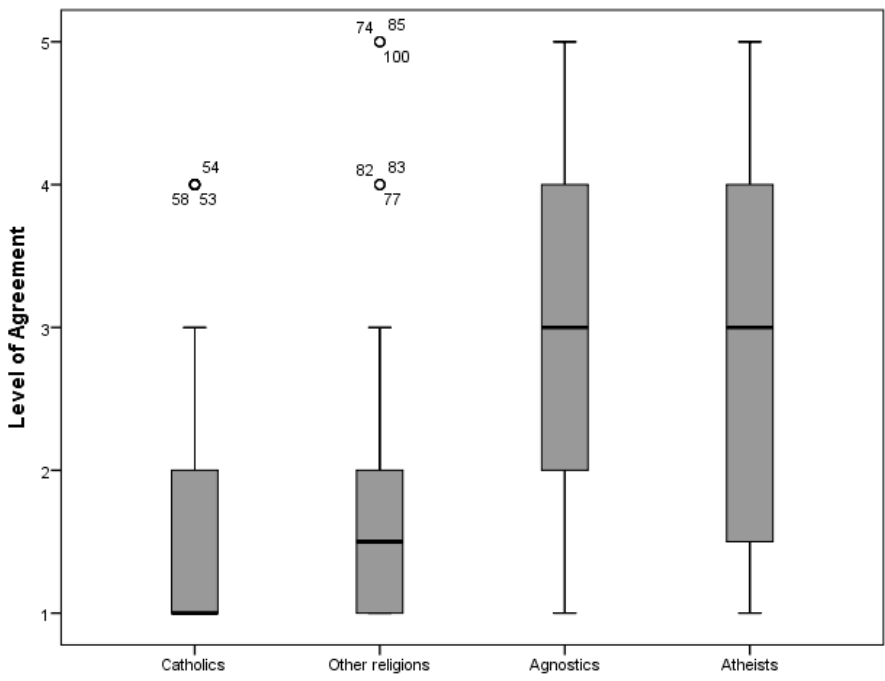
Figure 4. Box ‐ plots showing degree of agreement for different religious groups on rejecting human cloning (dots and asterisks indicate outliers and very atypical values).